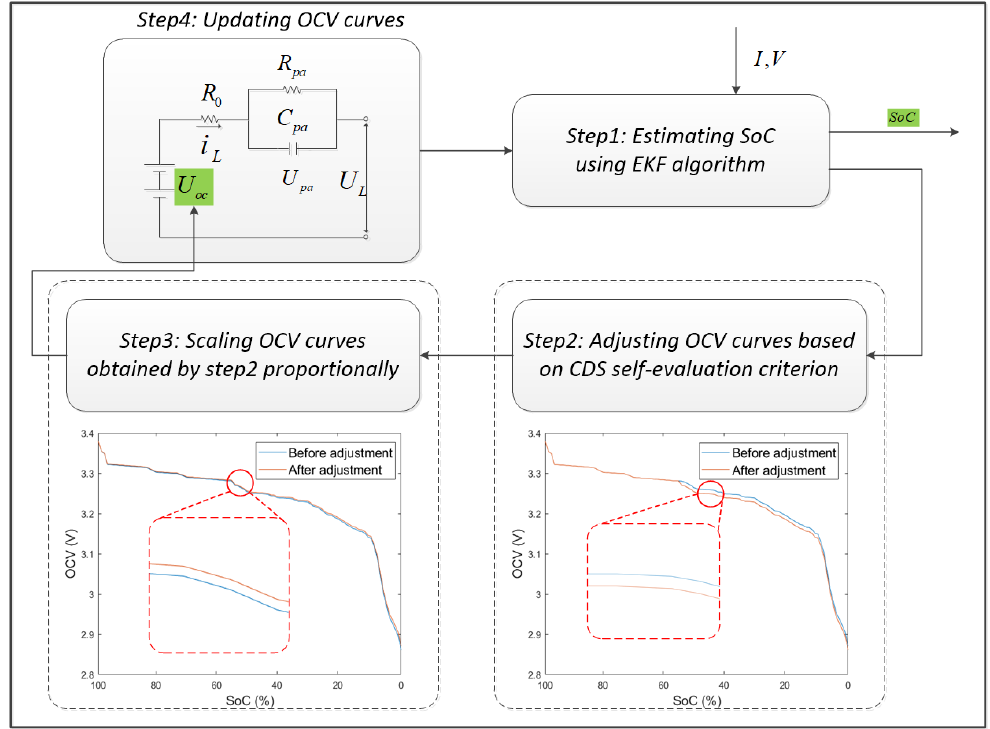
Figure 4. Flowchart of EKF with CDS self-evaluation